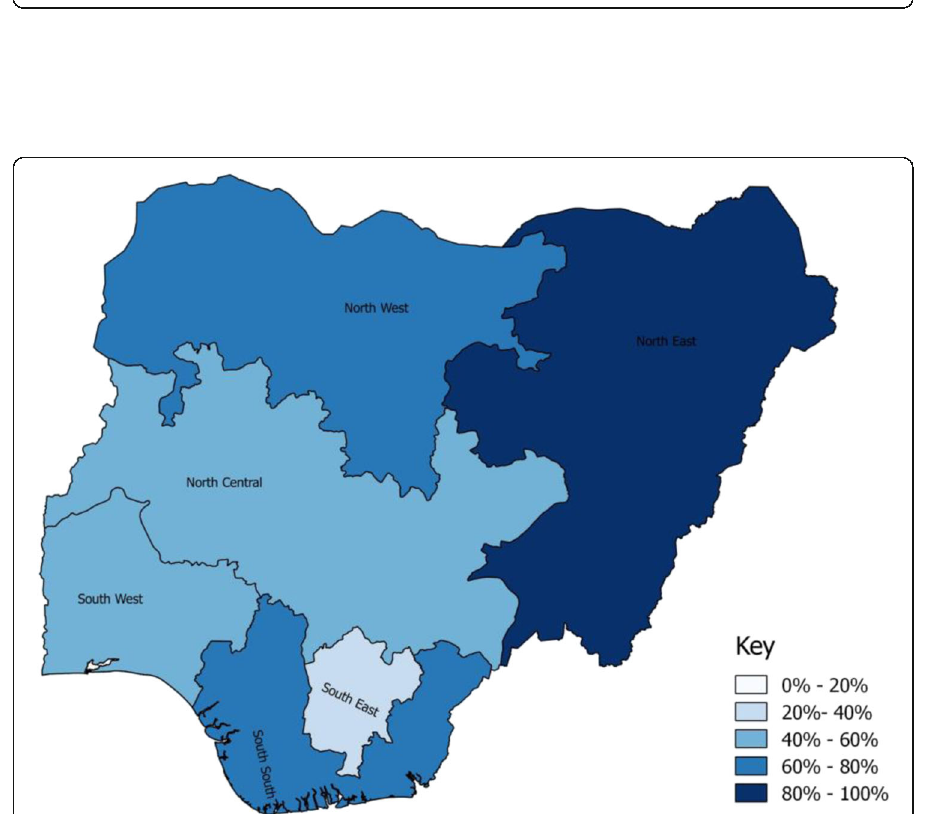
Fig. 5 Percentage of women believing that a husband is justified in beating his wife for any reason, by region, NDHS